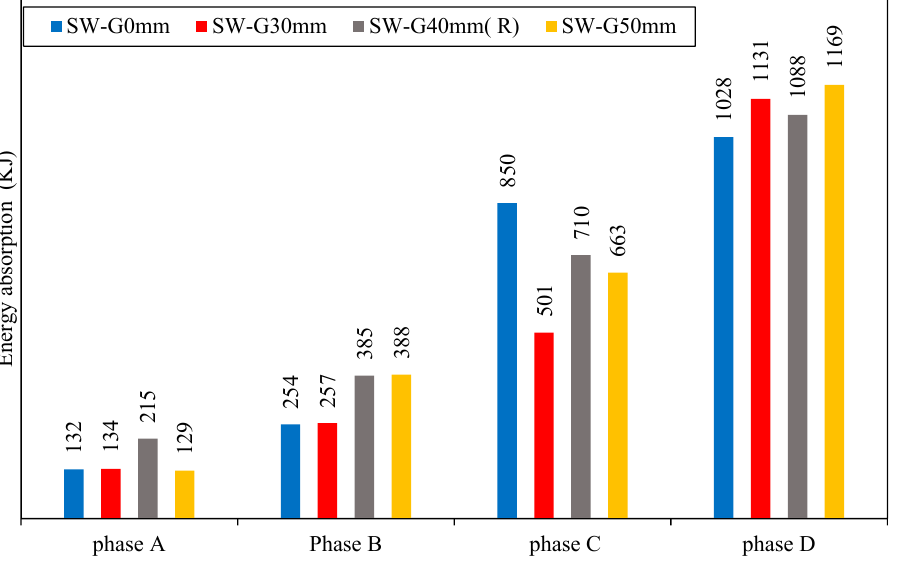
Figure 13. Energy absorption of group 1.